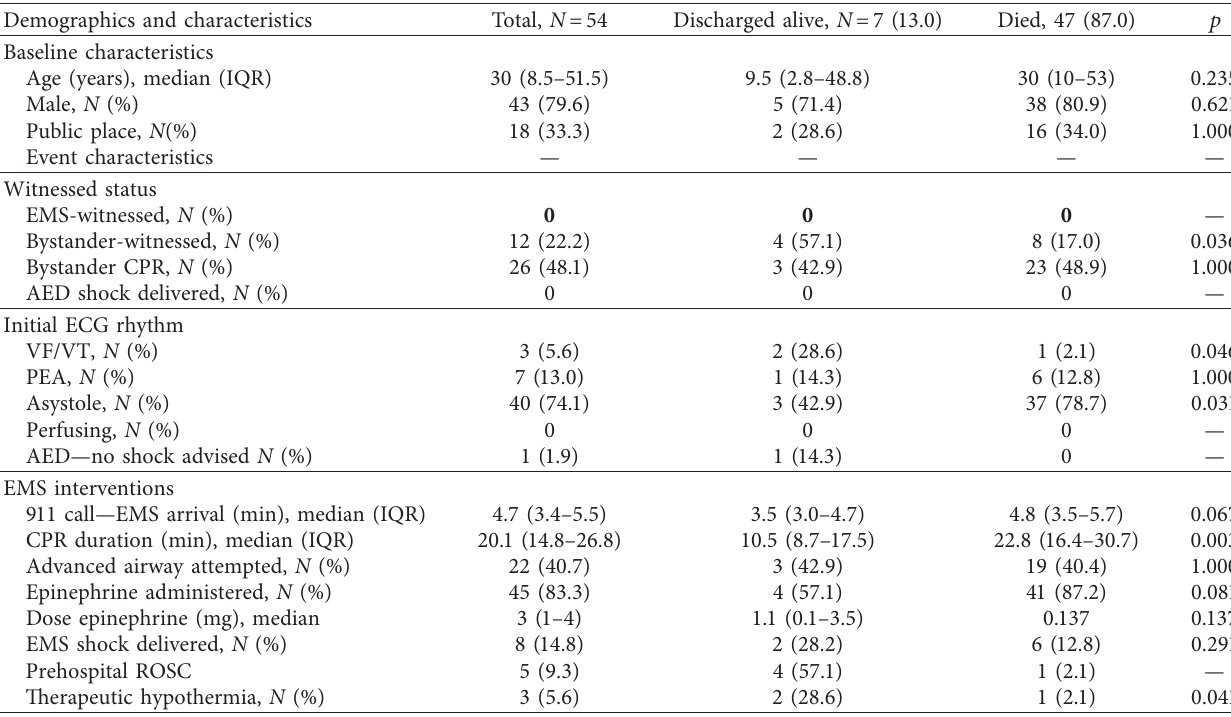
Table 1: Comparison of epidemiological characteristics of out-of-hospital cardiac arrest due to drowning. Demographics and